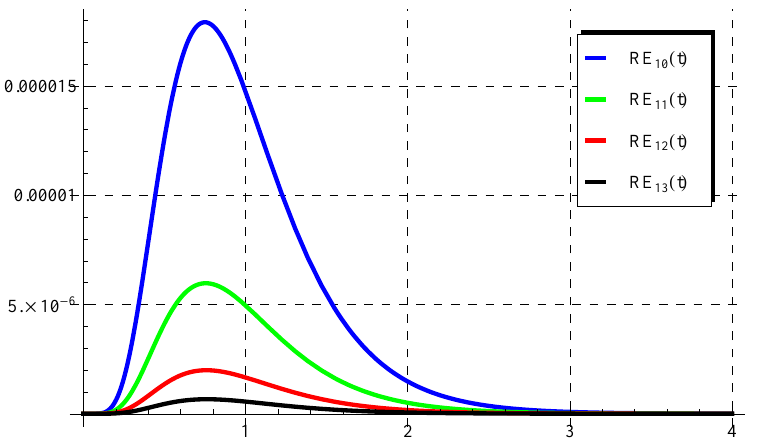
Figure 7. The residuals RE r ( t ) , r = 10,11,12,13 in Equation (76) at λ = 1, a = − 2, b = 1, and c = 3